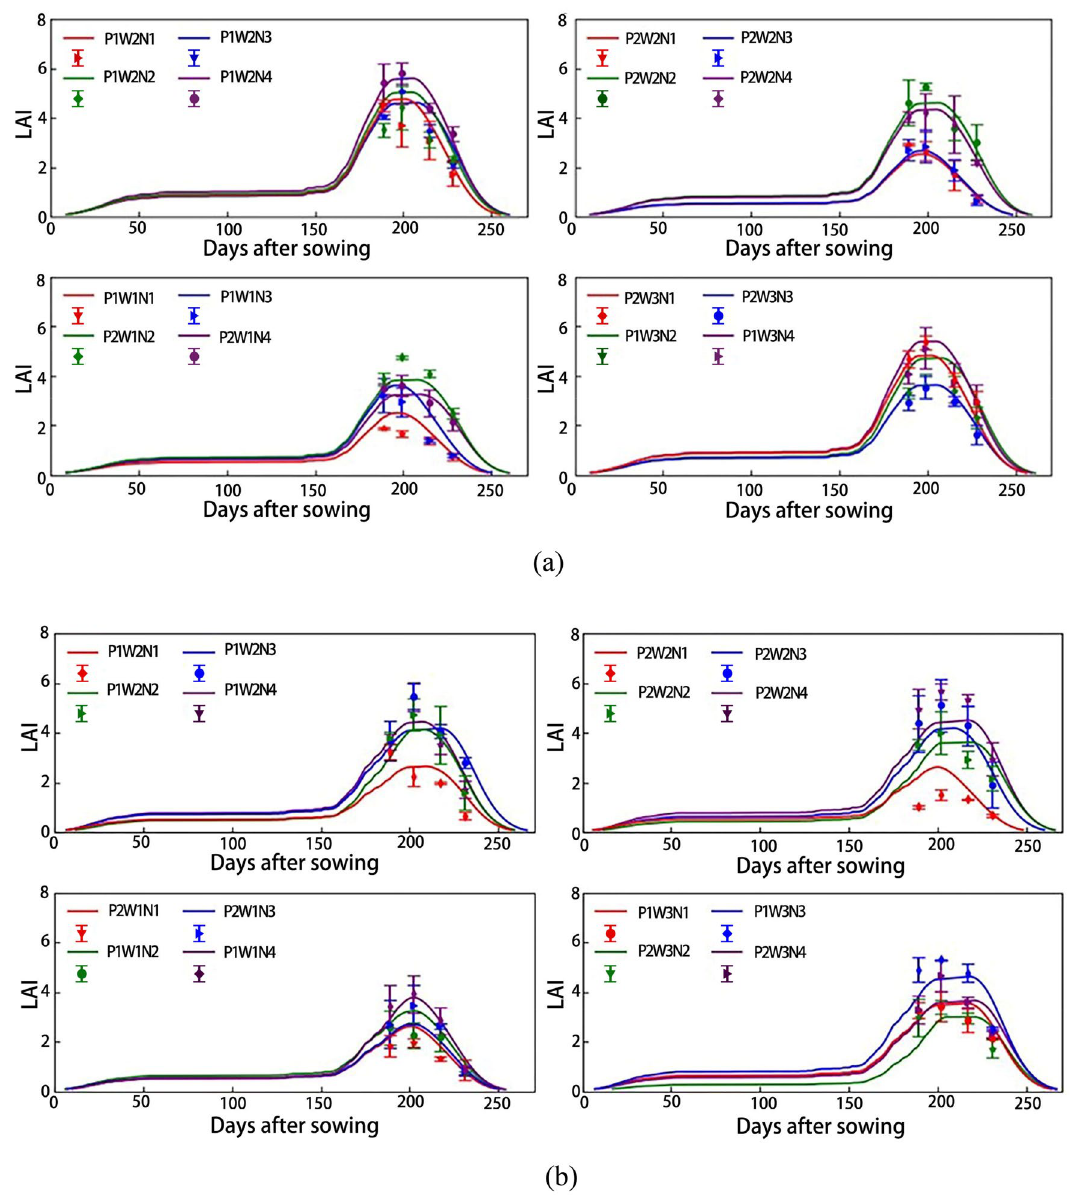
Figure 3. Relationships between estimated and measured values of wheat LAI for different wheat varieties and different irrigation and fertilizer settings in 2014 ( a ) and 2015 ( b